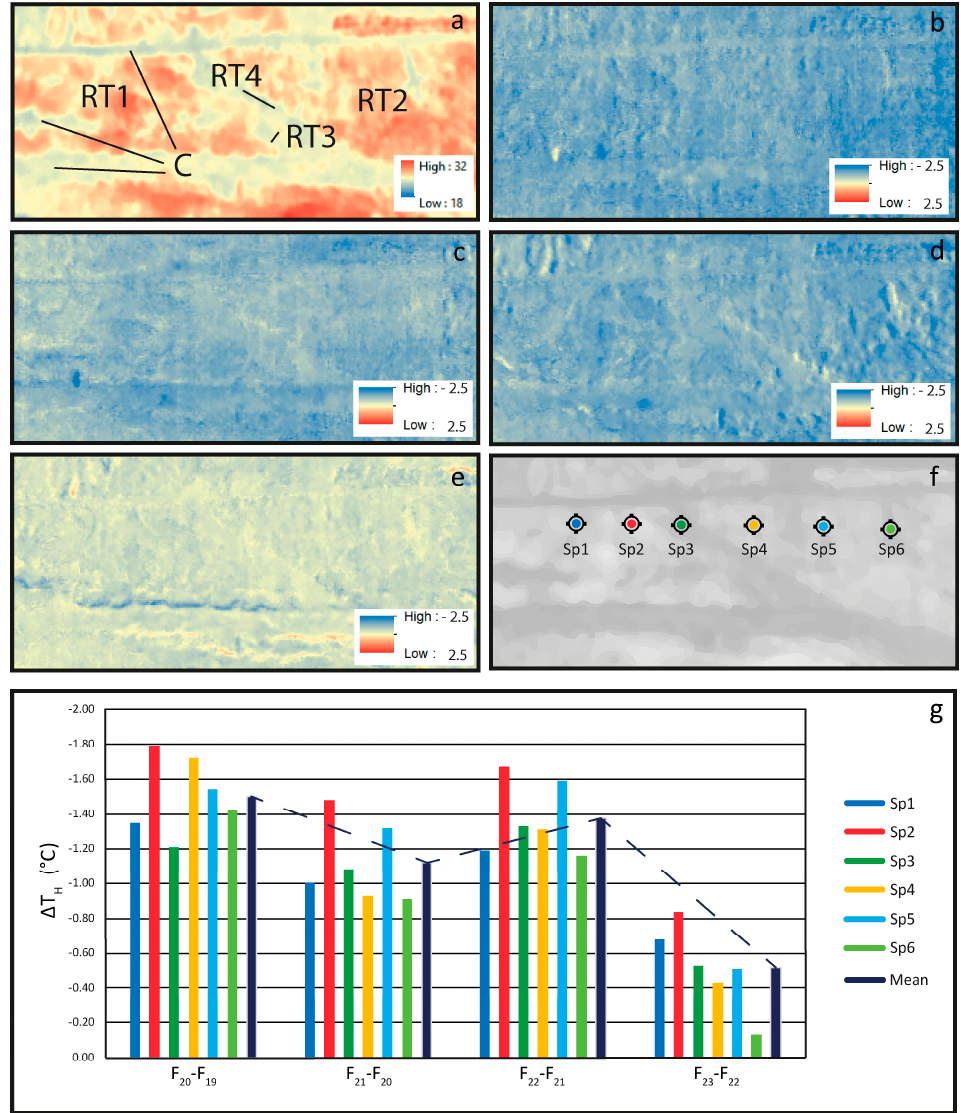
Figure 11. Summer measurement session 1-hour thermal differentials ∆ T H . ( a ) = image at 19:00 (F 19 ), ( b ) = F 20 -F 19 , ( c ) = F 21 -F 20 , ( d ) = F 22 -F 21 , ( e ) = F 23 -F 22 , ( f ) = position of measurement points, and ( g ) temperature differentials of the spot measurement points.